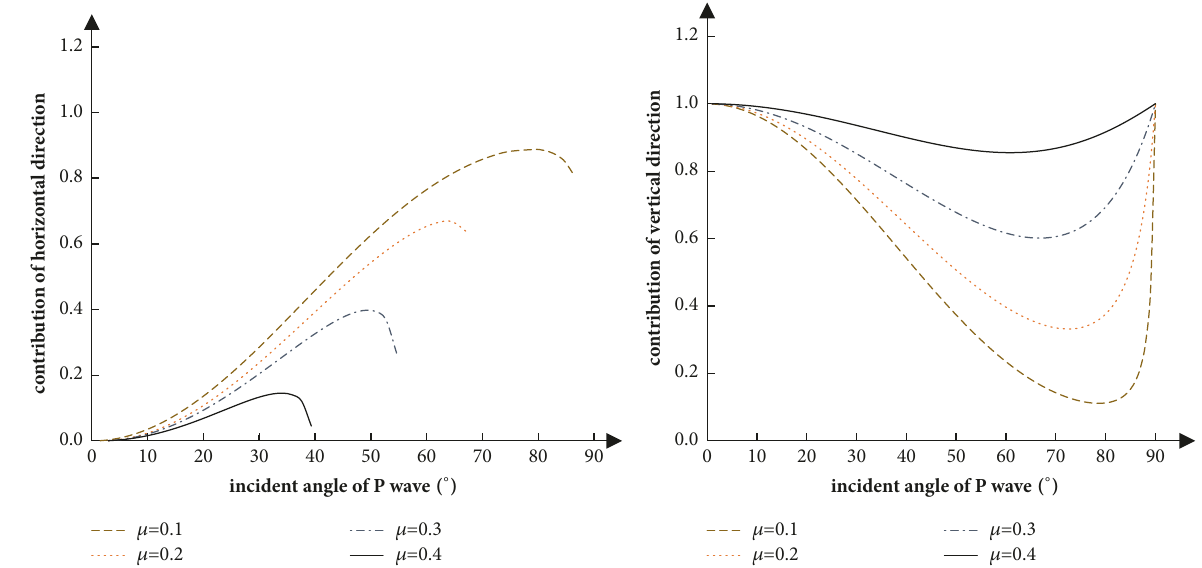
Figure 3: Contribution of P wave to the design ground motion on the free surface.